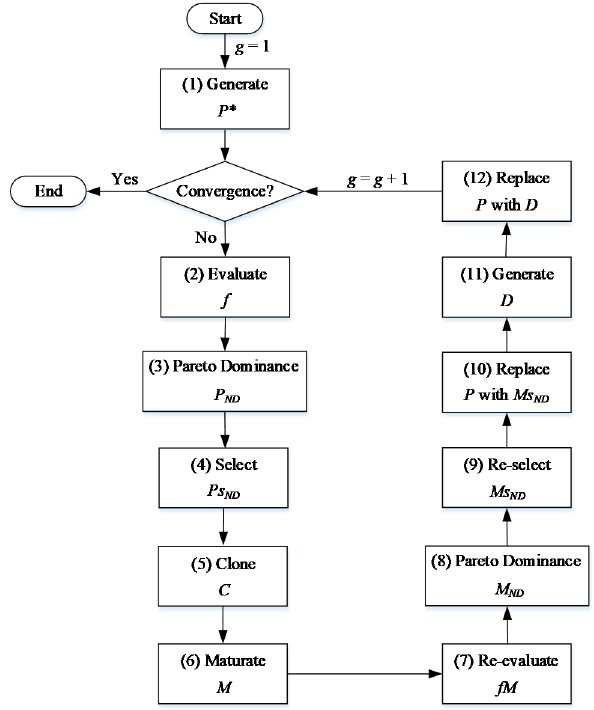
Figure 3. Proposed MOAIS flowchart.